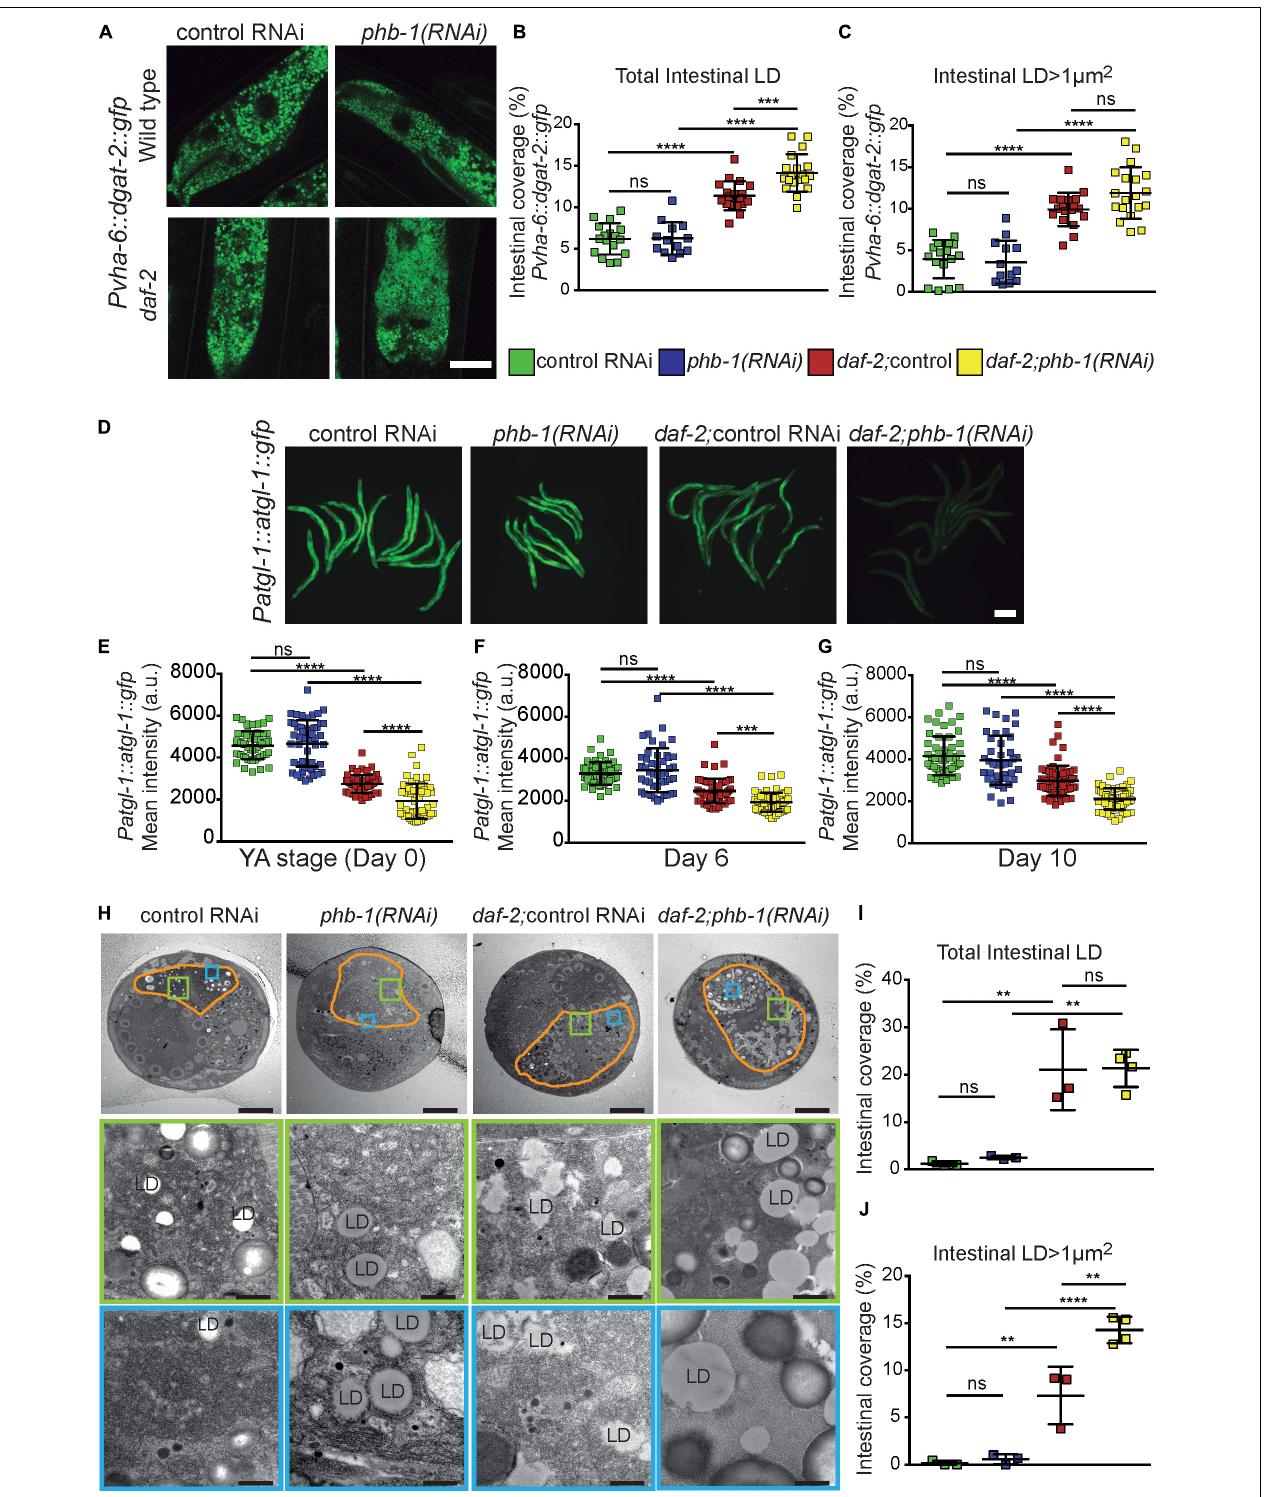
FIGURE 3 | PHB deficiency and/or daf-2(e1370) mutation differentially affect lipid droplets. (A) Representative images of DGAT-2:GFP-labeled lipid droplets (LD) at the YA stage (Scale Bar: 20 µ m). (B,C) Quantification of LD coverage (%) given by the ratio between the sum of the area of intestinal LDs versus the worm intestinal area times 100. All LDs (B) and LDs larger than 1 µ m 2 (C) . Mean values from at least two independent biological replicates; error bars denote SD. ANOVA with